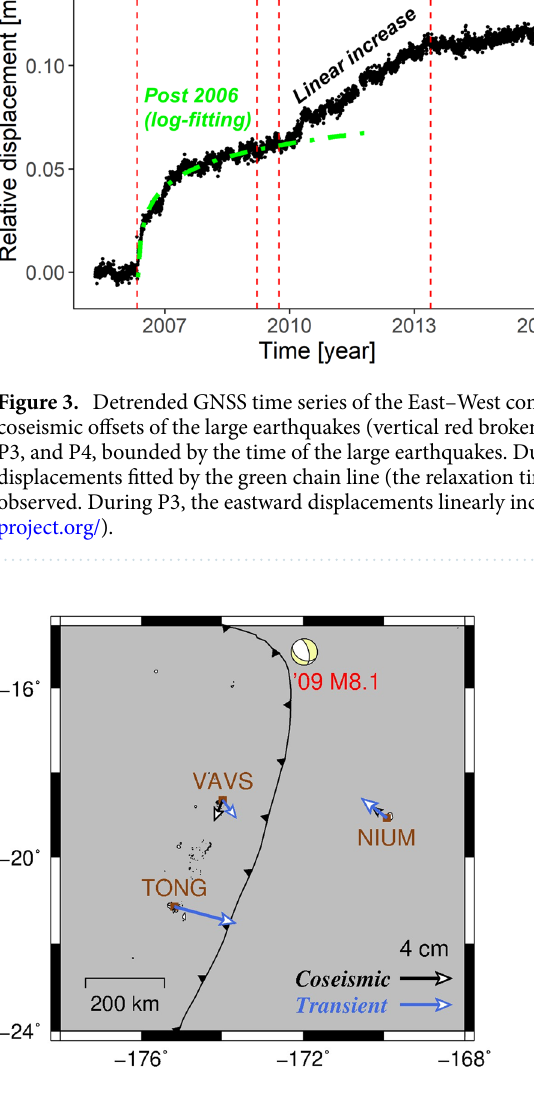
Figure 4. Displacement vectors associated with the M8.1 earthquake on 29 September 2009. The coseismic (black arrows) and transient displacements during period P3 (blue arrows) are mapped. Figure generated with Generic Mapping Tools 5.x (https ://www.gener ic-mappi ng-tools